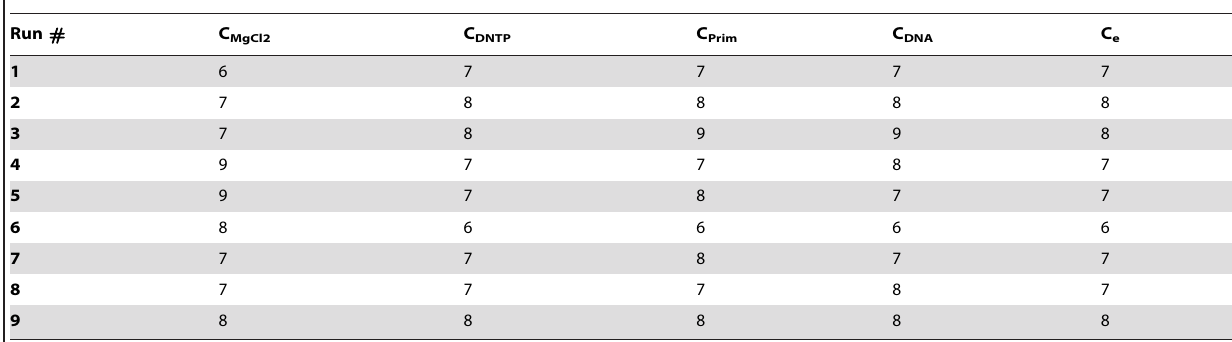
Table 2. Rank-ordered amplicon data*.